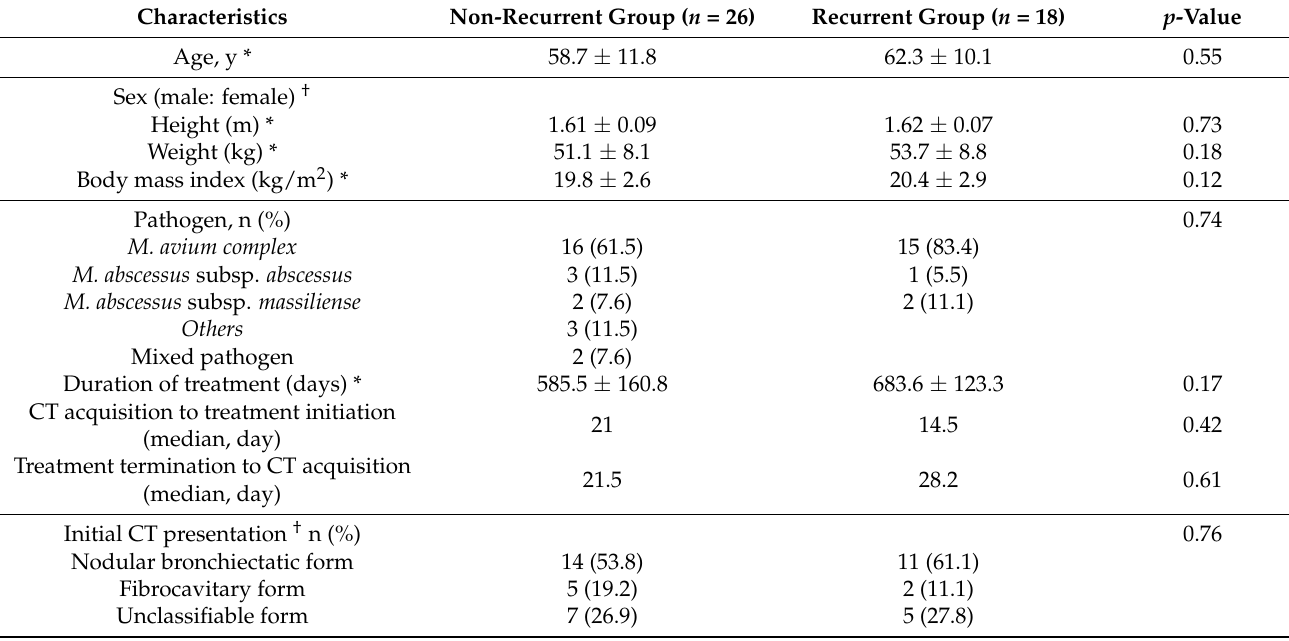
Table 1. Baseline characteristics of patients with and without recurrent nontuberculous mycobacterial pulmonary disease.